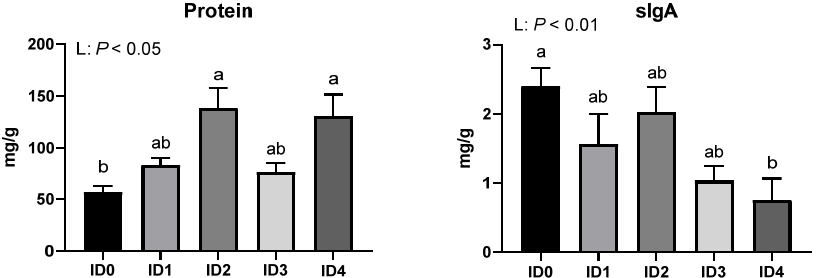
Figure 7. Effects of different infection doses of Eimeria tenella on concentration of protein and secretory immunoglobulin A (sIgA) in the cecal contents of broilers 6 days post-infection. Concentration of protein and secretory immunoglobulin A (sIgA) were measured in the ID0 (infection dose 0; sham-challenged with phosphate-buffered saline); ID1 (infection dose 1; challenged with 6250 sporulated oocysts of Eimeria tenella ); ID2 (infection dose 2; challenged with 12,500 sporulated oocysts of E. tenella ); ID3 (infection dose 3; challenged with 25,000 sporulated oocysts of E. tenella ); ID4 (infection dose 4; challenged with 50,000 sporulated oocysts of E. tenella ) groups. Data were analyzed by using One-way ANOVA followed by the Tukey’s multiple comparison test and means with different letters (a and b) differ significantly ( p < 0.05). Orthogonal polynomial contrast analysis was used to assess linear (L) and quadratic (Q) effects of the infection doses, and p < 0.1 were presented.